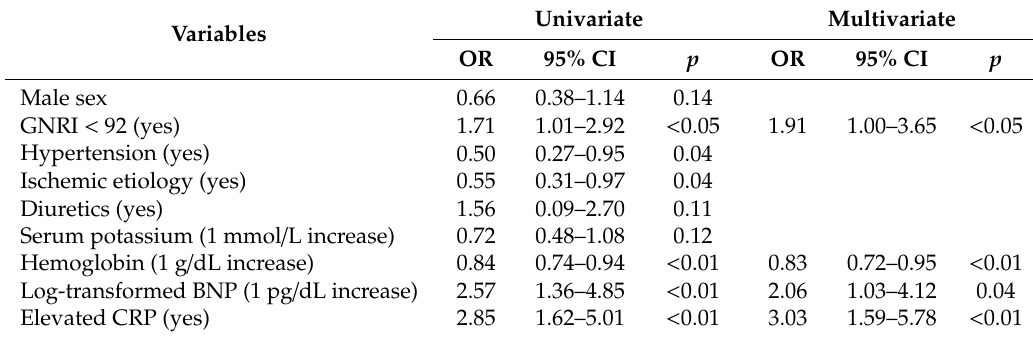
Table 6. Univariate and multivariate analyses of factors associated with longer length of hospital stay in